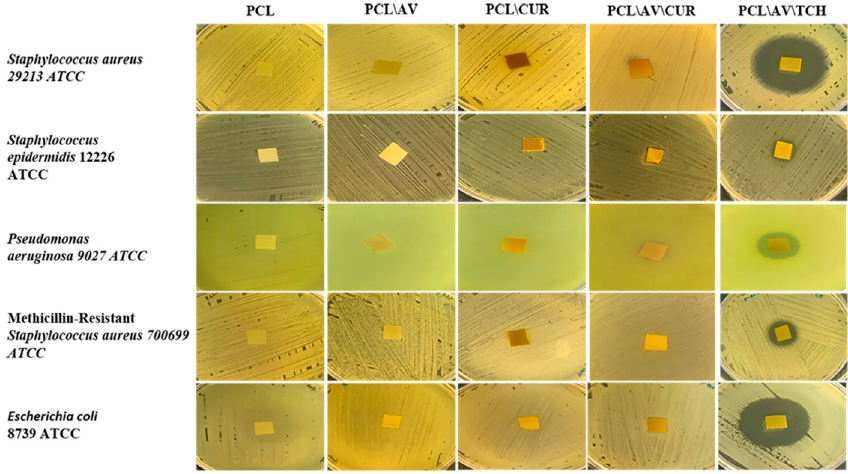
Figure 10. Antimicrobial efficacy of biocomposite nanofibrous scaffolds PCL, PCL/AV, PCL/CUR, PCL/AV/CUR and PCL/AV/TCH.